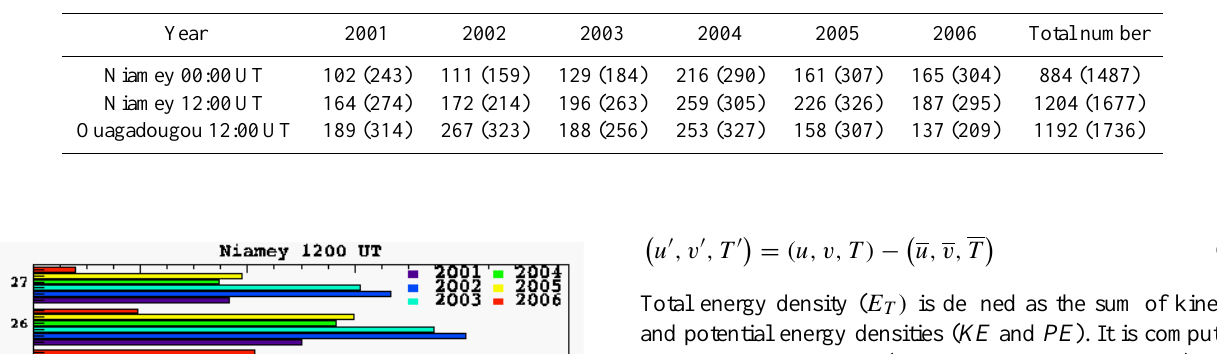
Table 1. Number of selected profiles and raw dataset in the Lower Stratosphere at heights between 19 and 23km at Niamey (00:00UT and 12:00UT) and Ouagadougou (12:00UT) from 2001 to 2006. Numbers of raw data are within parentheses.